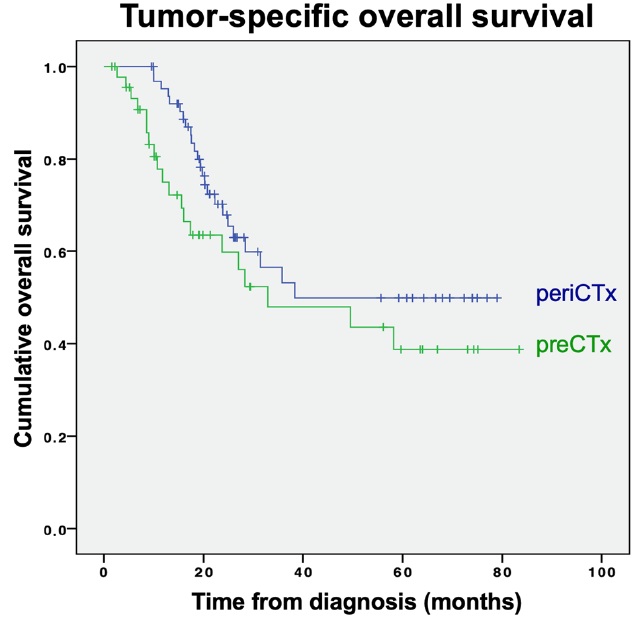
Figure 3. Tumor ‐ specific overall survival for patients receiving perioperative (periCTx, blue line) or preoperative chemotherapy (preCTx, green line).